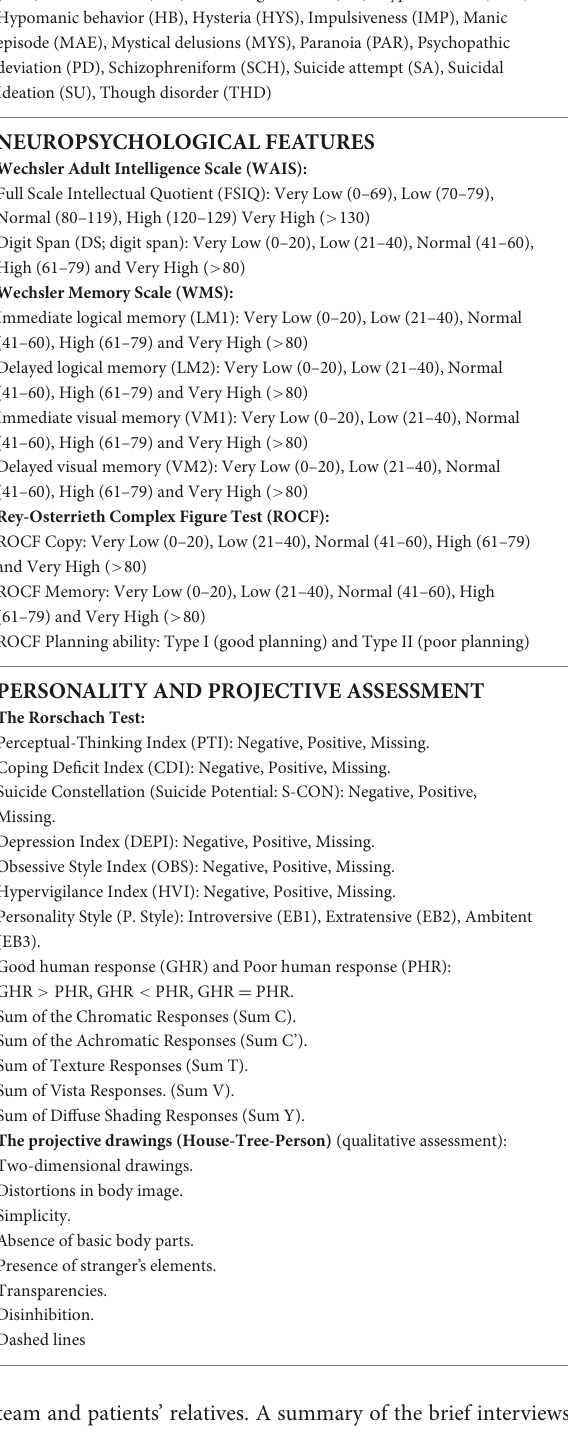
TABLE 2 Set of variables selected for psychological